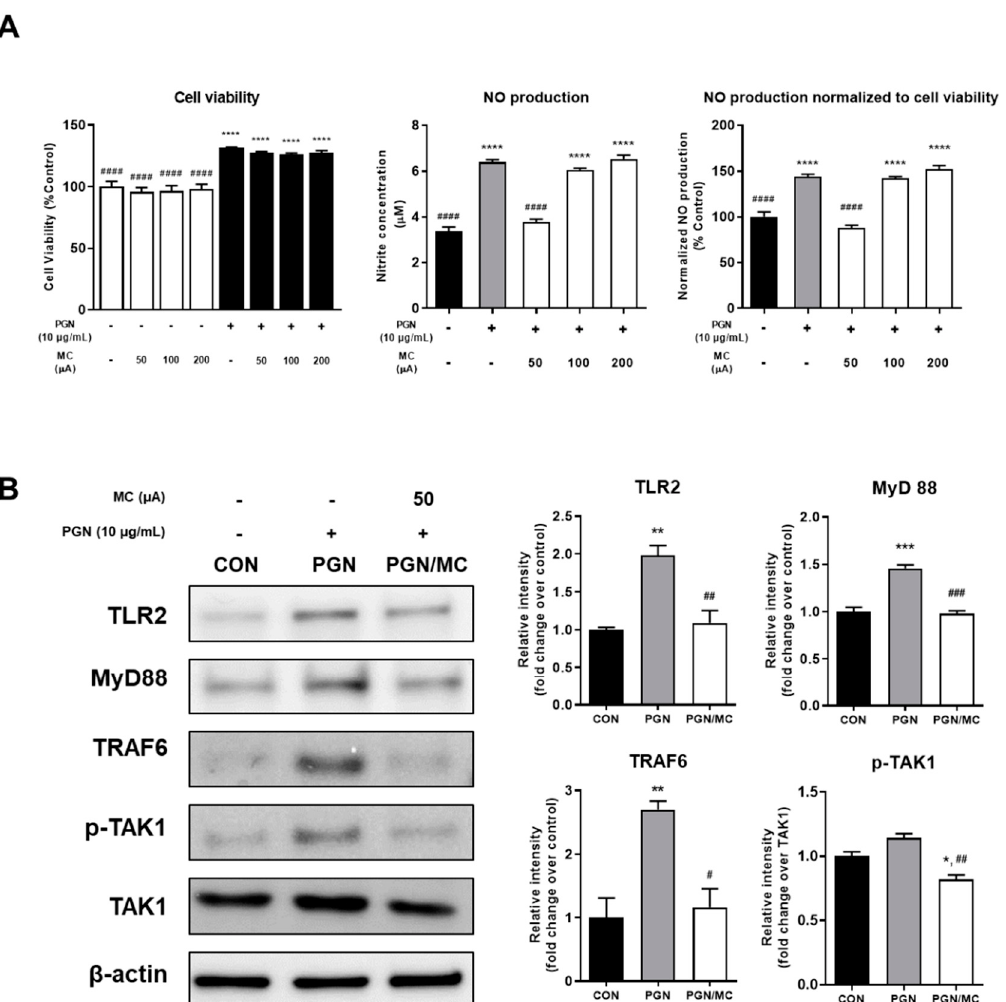
Figure 1. ( A ) To determine the cytotoxicity of PGN or MC in Raw 264.7 cells, the presence or absence of PGN treatment or various levels of MC were applied to the Raw 264.7 cells. The cell was subsequently cultured for 12 h and incubated further with WST-1 reagent for an additional 1 h. To compare NO production at various levels of MC, Raw 264.7 cells were pre-treated with PGN (10 µ g/mL) for 30 min and applied with MC for 1 h. After 12 h, the amount of NO production was measured by the Griess assay. **** p < 0.0001 vs. negative control. #### p < 0.0001 vs. positive control. The values shown represent the mean ± SD of triplicate measurements of separate experiments. Values are shown as % of the negative control. ( B ) Immunoblot analysis of TLR2 related proteins on Raw 264.7 cells following the application of MC. The graph represents the quantitative level of the proteins. * p < 0.05, ** p < 0.01, *** p < 0.001 vs. control group. # p < 0.05, ## p < 0.01, ### p < 0.001 vs. positive